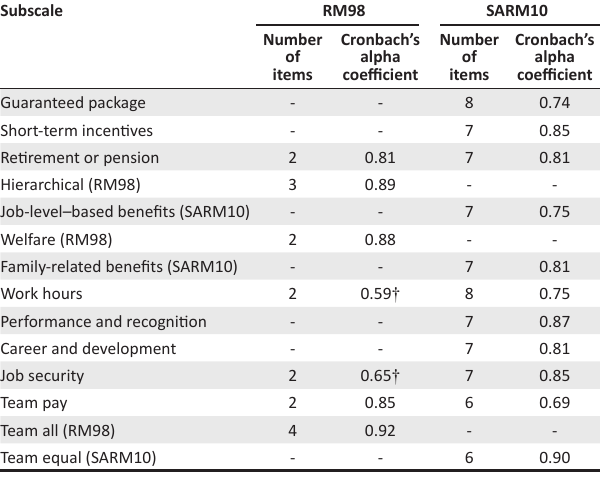
TABLE 3: RM98 (Herkenhoff, 2000) and SARM10 subscale reliabilities.